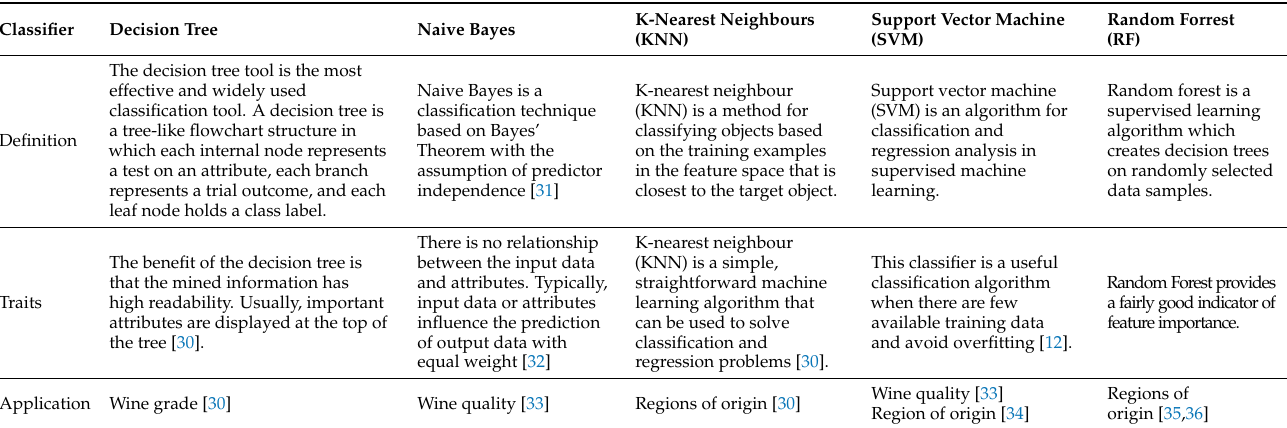
Table 2. The usage of machine learning